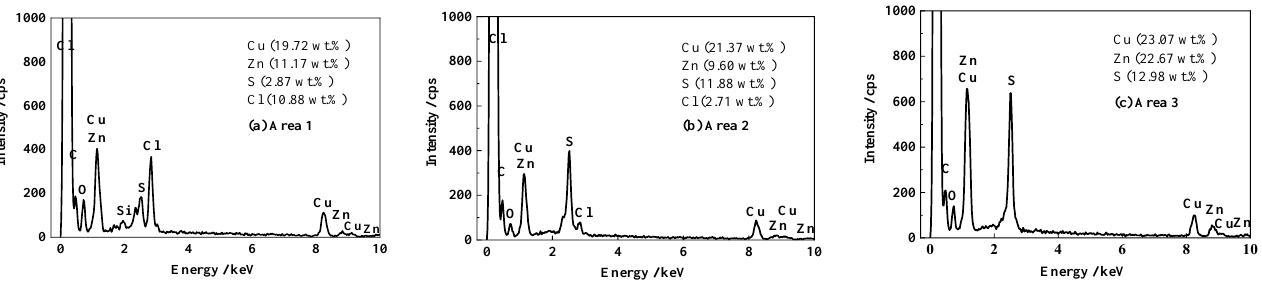
Figure 5. EDS results of FW1 antifouling coating after 1700 d: ( a ) the surface of antifouling coating; ( b ) cross-sectional leached layer of topcoat; ( c ) cross-sectional inner layer of topcoat.